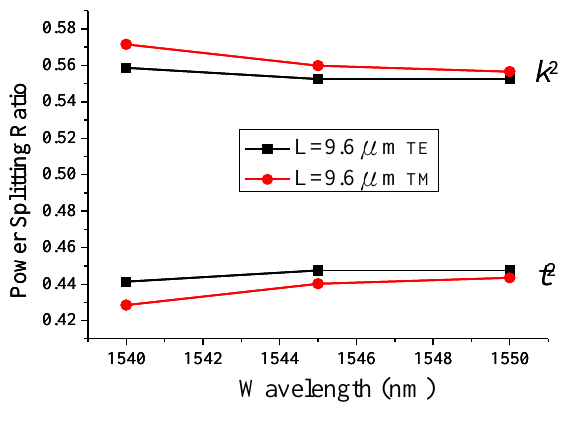
Figure 2. FDTD simulated MMI coupler